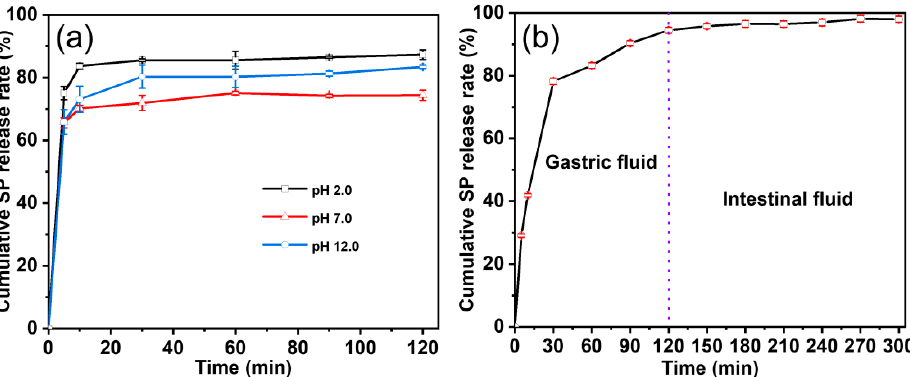
Figure 5. The cumulative release curves of SP released from DX-WPI-SP microcapsules under ( a ) the different pH values (pH 2.0, pH 7.0, and pH 12.0) and ( b ) the simulated gastric and intestinal digestion surroundings.